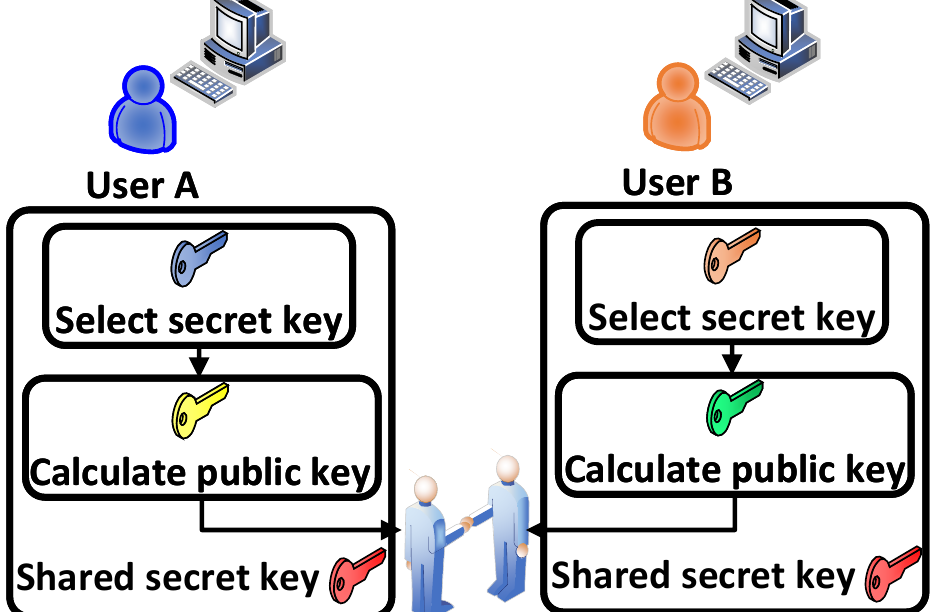
Figure 1. General structure of